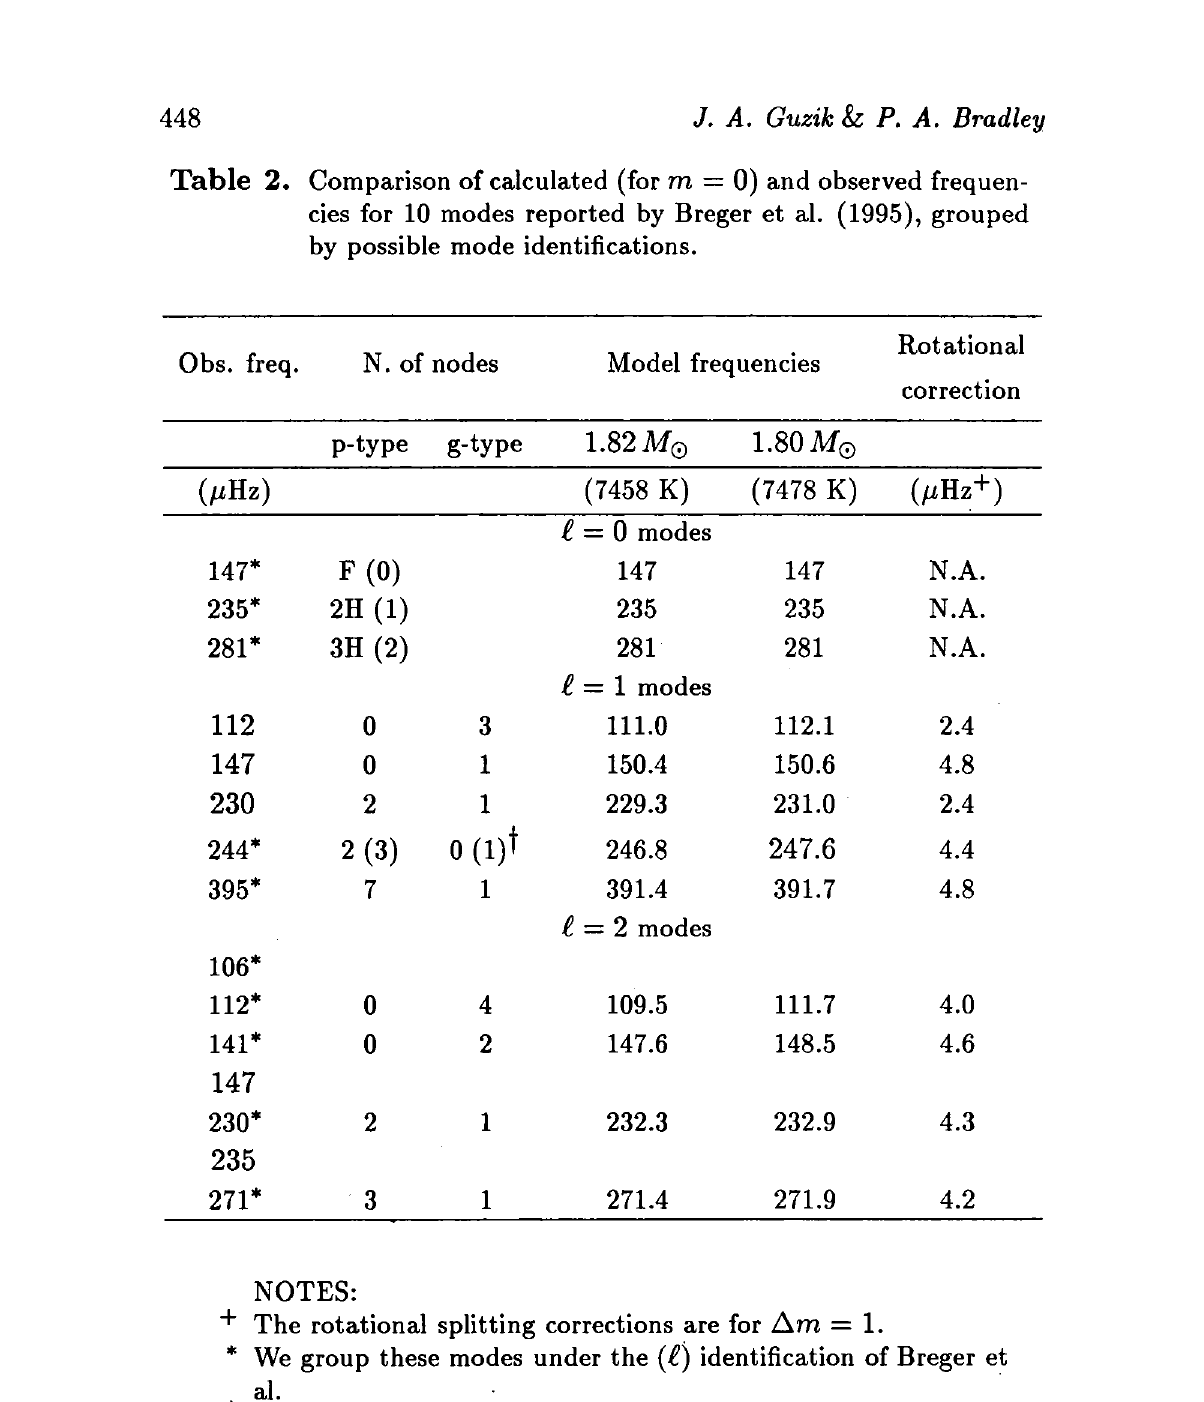
Table 2. Comparison of calculated (for m = 0) and observed frequen- cies for 10 modes reported by Breger et al. (1995), grouped by possible mode